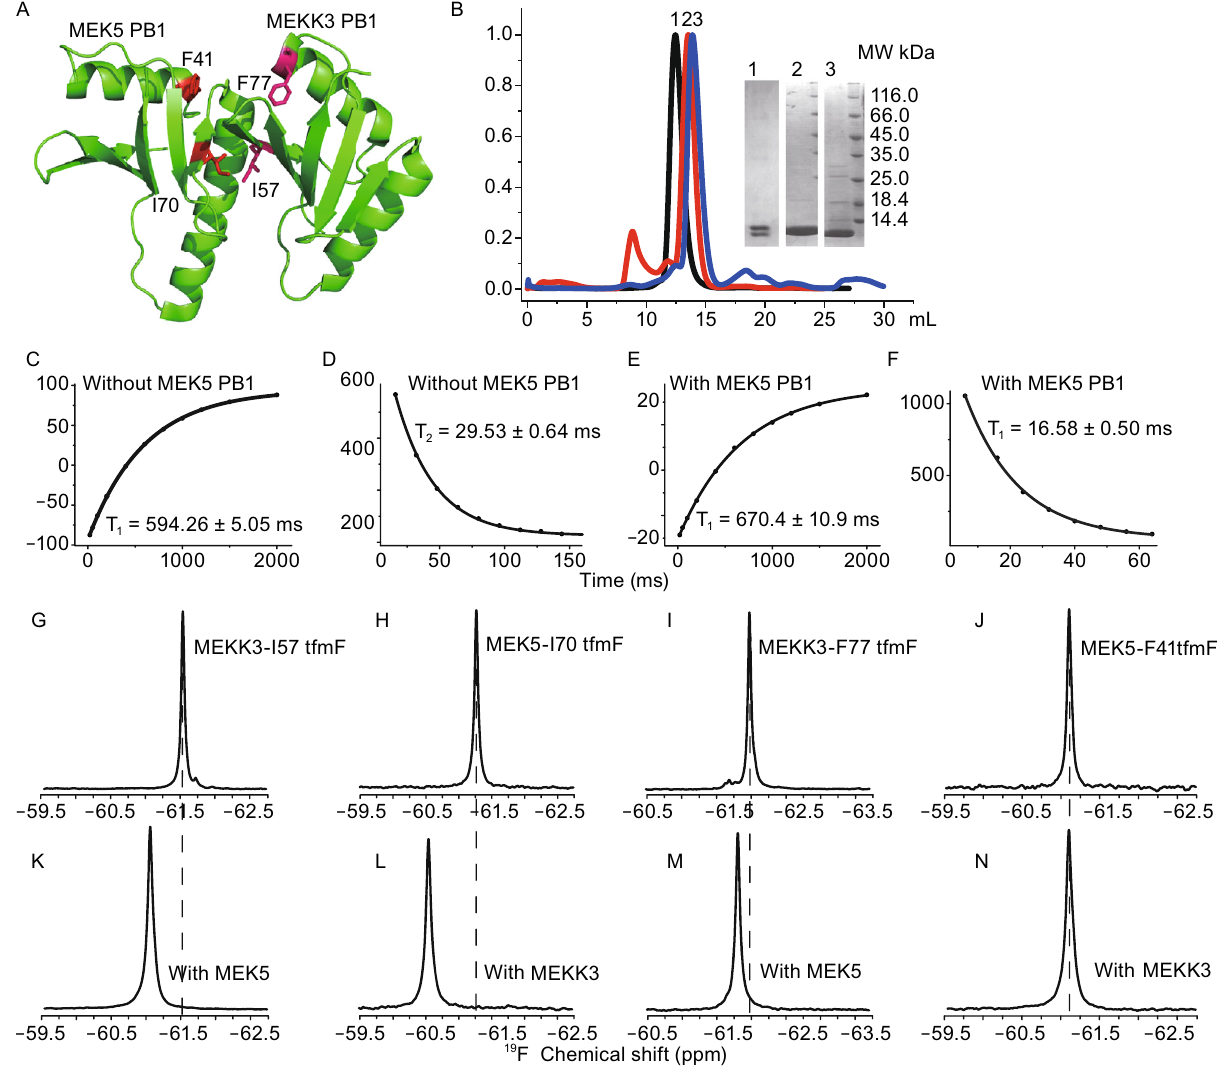
Figure 1. 19 F chemical shift perturbations and relaxation values of site-speci fi c tfmF incorporation in puri fi ed MEKK3-PB1